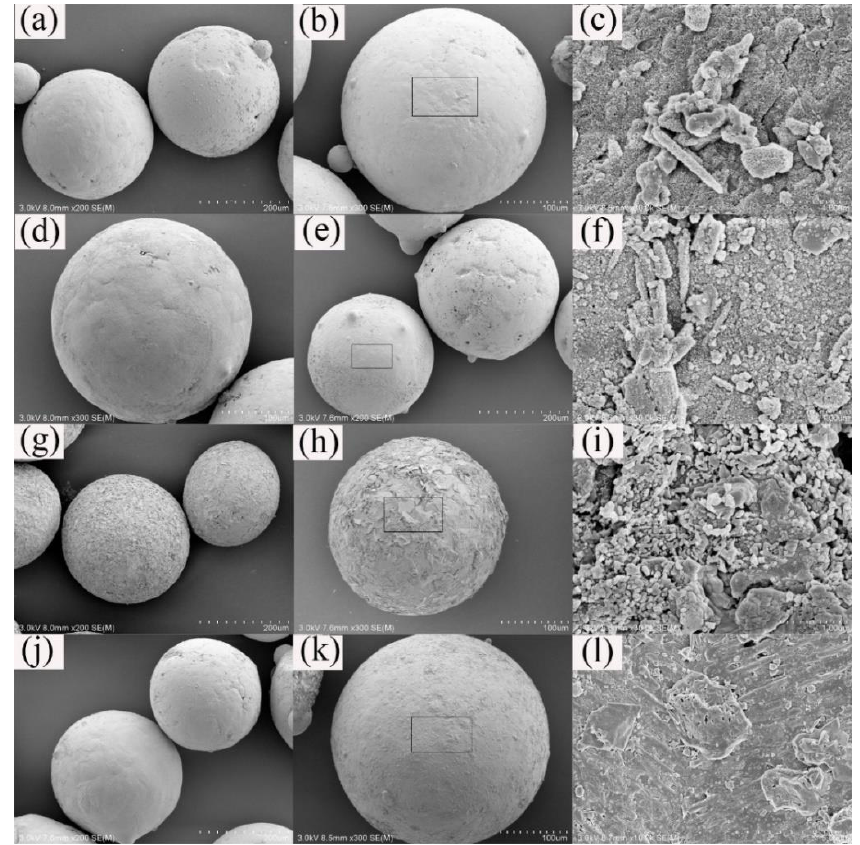
Figure 8. Microstructure of the sample (( a ) 24 h in water; ( b , c ) 72 h in water; ( d ) 24 h in acid; ( e , f ) 72 h in acid; ( g ) 24 h in alkali; ( h , i ) 72 h in alkali; ( j ) 24 h in polishing fluid; and ( k , l ) 72 h in polishing